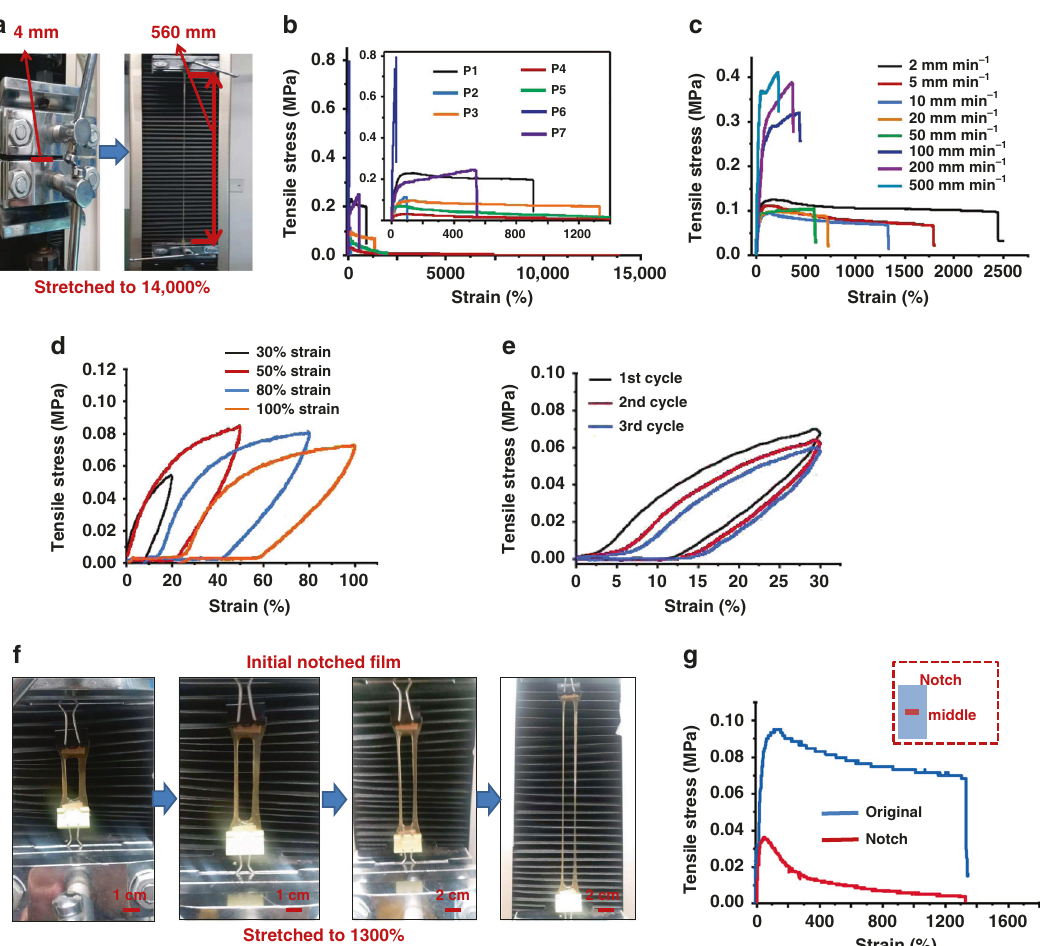
Fig. 2 Mechanical properties of PDMS – SS – IP – BNB elastomer. a Photographs of a PDMS – SS – IP – BNB elastomer fi lm (P4) before and upon stretching. b Stress – strain curves of PDMS – SS – IP – BNB elastomer fi lms prepared with different molar ratios. c Stress – strain curve of the PDMS – SS – IP – BNB elastomer fi lm (P3) at different speeds. Sample width, 14 mm; thickness, 1 mm; gage length, 2 mm. d Stress – strain curves of the fi lm (P3) in stress – strain tests (20%, 50%, 80%, 100% strain) in successive stretching. e The stress – strain curve of the fi lm (P3) in cyclic stress – strain tests (30% strain) in successive stretching. Sample width, 14 mm; thickness, 1 mm; gage length, 40 mm. Stretching speed, 10 mm min − 1 . f, g A notch-insensitive and highly stretchable elastomer fi lm (P3). A notch (8 × 8 mm 2 ) with 2 mm thickness, 20 mm length, and 16 mm width (left) was made in the P3 fi lm, and the fi lm was stretched at a loading rate of 10 mm min − 1 . The inset graph is the schematic diagram of notch location. Source data are provided as a Source Data fi